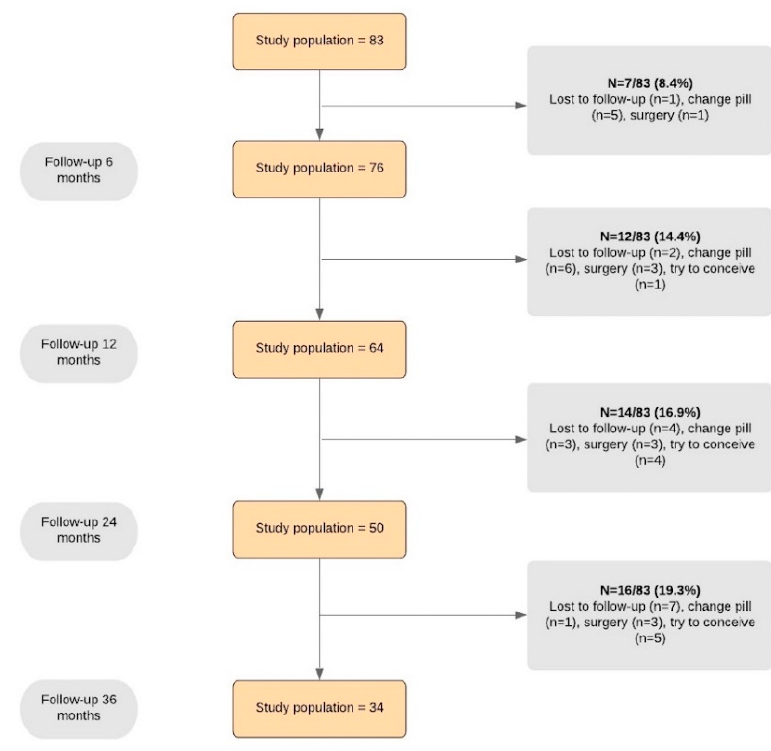
Figure 1. Flow chart showing women’s progress through the study.